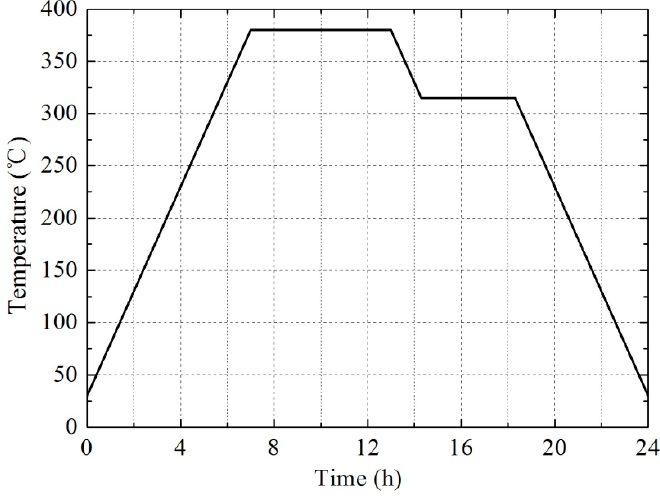
Figure 1. The temperature steps of a sintering cycle.